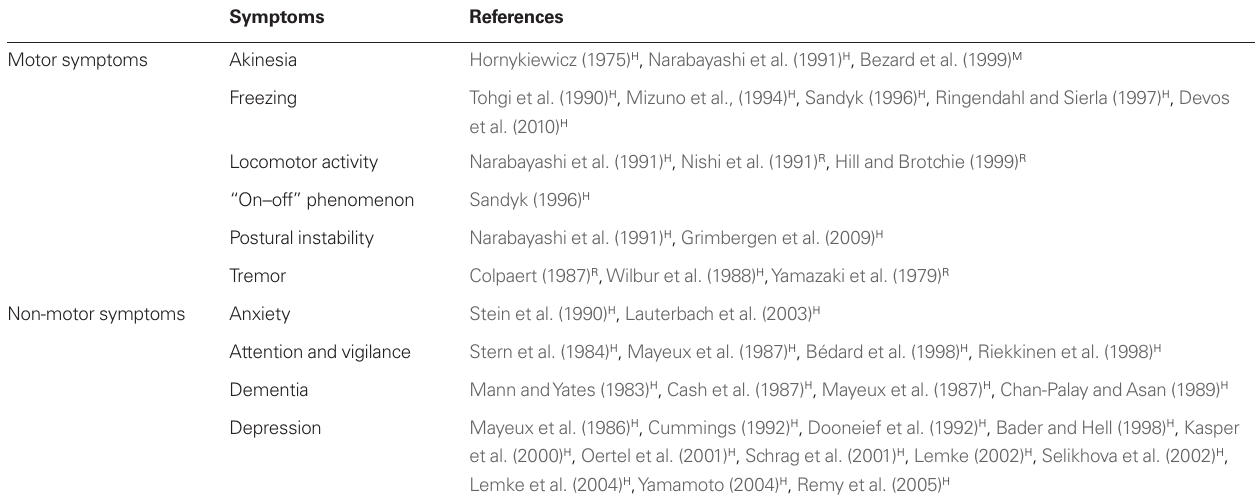
Table 2 | involvement of the LC in specific motor and non-motor symptoms of PD and their reference studies.